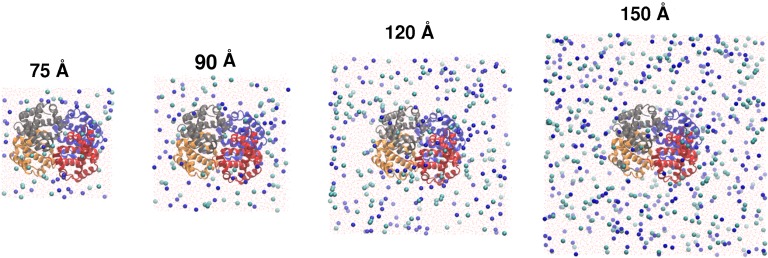
Tetrameric hemoglobin solvated in boxes of different sizes.Tetrameric hemoglobin solvated in boxes of size: (from left to right) 75, 90, 120 and 150 Å. Spheres correspond to Na+ and Cl− ions, added to neutralize the system and to achieve a biologically appropriate salt concentration of 0.15 mol/L.